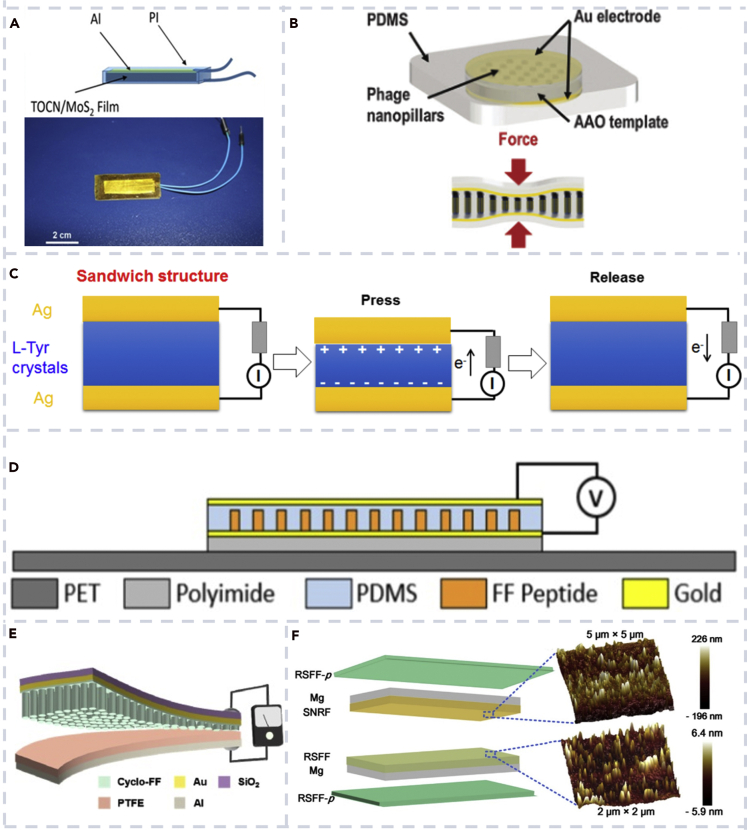
Biocompatible nanogenerator based on different biomolecules(A) Schematic diagram of a TOCN/MoS2 nanogenerator (Wu et al., 2021).(B) Schematic of a phage nanopillar-based nanogenerator (Shin et al., 2015).(C) The sandwich structure of an L-Tyr crystal-based nanogenerator and its energy conversion process (Ji et al., 2019).(D) Schematic of the FF peptide nanogenerator attached to a PET beam (Jenkins et al., 2018).(E) Schematic view of a TENG based on Cyclo-FF nanowire arrays (Park et al., 2019).(F) Schematic illustration of a biocompatible TENG using silk nanofibrils (Niu et al., 2020).